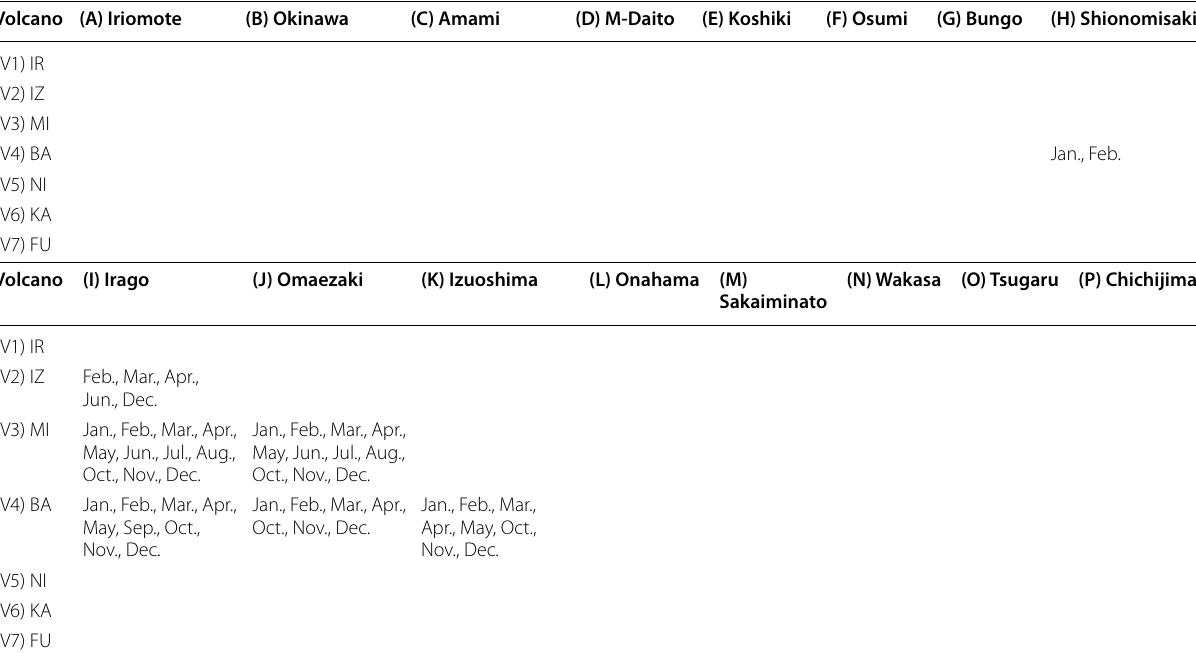
Table 5 Paths for which the number of yearly mean virtual pumice arrivals was larger than 100 and the standard deviation of the duration in a given month was 2 months greater or less than the yearly mean Volcano (A)